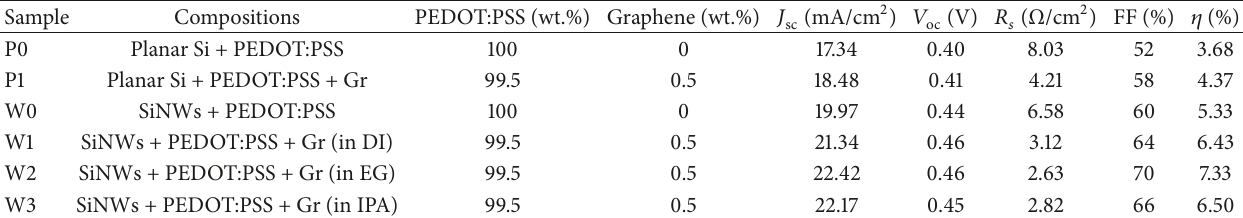
Figure 1: Schematic diagram of the fabrication process of PEDOT:PSS/SiNW hybrid solar cell containing functionalized graphene. Table 1: Chemical composition and photovoltaic properties of the prepared hybrid solar cells: short circuit current density ( 𝐽 sc ), open circuit voltage ( 𝑉 oc ), series resistance ( 𝑅 𝑠 ), Fill factor (FF), and efficiency ( 𝜂 ). Sample